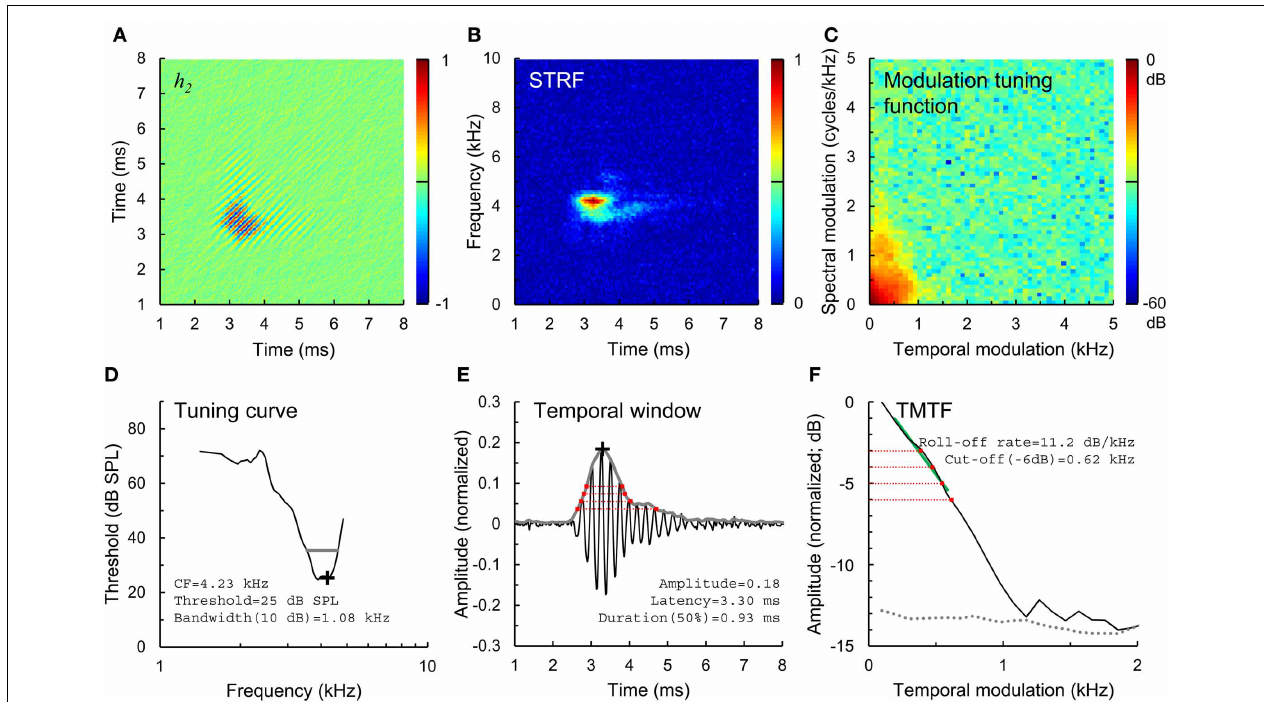
FIGURE 1 | Estimation of temporal envelope coding. (A) 2nd-order Wiener kernel ( h 2 ), computed from 2nd-order cross correlation of a broadband Gaussian noise stimulus and spike train response of a normal-hearing auditory-nerve fiber. Time axes ( A,B,E ) indicate time relative to the occurrence of a spike, and are plotted from a lower limit of 1ms rather than 0ms to more clearly show the structure of the kernels. Normalized amplitude color scales (A–C) are drawn to the right of each panel. (B) Spectro-temporal receptive field (STRF), or mean stimulus spectrogram preceding a spike, calculated from h 2 . (C) Modulation tuning function, calculated from the STRF. (D) Tuning curve showing threshold